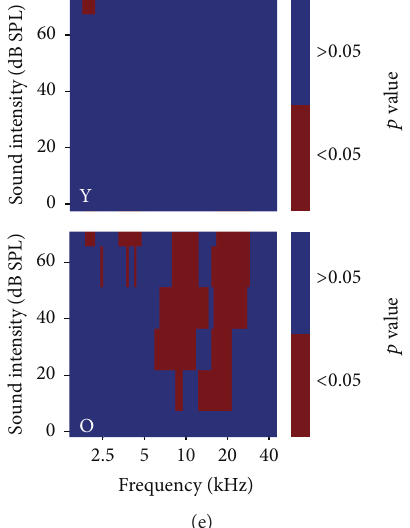
Figure 3: Impact of training and rivastigmine on A1 frequency tuning. (a) Representative A1 characteristic frequency (CF) maps from na¨ıve (untrained), trained with saline (TS), and trained with rivastigmine (TR) young and older rats. Bolded polygons have a CF at the target tone ± 0.3 octaves. Hatched polygons have a CF at the nontarget tone ± 0.3 octaves. Note the increase in map area to the nontarget tone in the O-TS group only. (b) Difference in A1 area tuned to various frequencies between each experimental group and untrained animals. The full arrow points to the target frequency; the hatched arrow points to the nontarget frequency. Note how in each group except O-TS there is a significant reduction in area tuned to the nontarget frequency. (c) Percentage of A1 activated by every frequency-intensity combination used for mapping in all experimental groups. (d) Difference in the percent of activation between Y-TS and Y-TR ( top ) and O-TS and O-TR ( bottom ). (e) Plot showing statistically significant difference in A1 activation in the young (top) and older (bottom) groups. Scale bar represents 1mm. D: dorsal; C: caudal; R: rostral; V: ventral (Y-UT: 𝑛 = 8 , recorded sites = 435; Y-TS: 𝑛 = 5 , recorded sites = 257; Y-TR: 𝑛 = 6 , recorded sites = 312; O-UT: 𝑛 = 8 , recorded sites = 412; O-TS: 𝑛 = 5 , recorded sites = 261; O-TR: 𝑛 = 5 , recorded sites = 249). Values shown are mean ± SE. ∗ 𝑝 < 0.05 : 𝑡